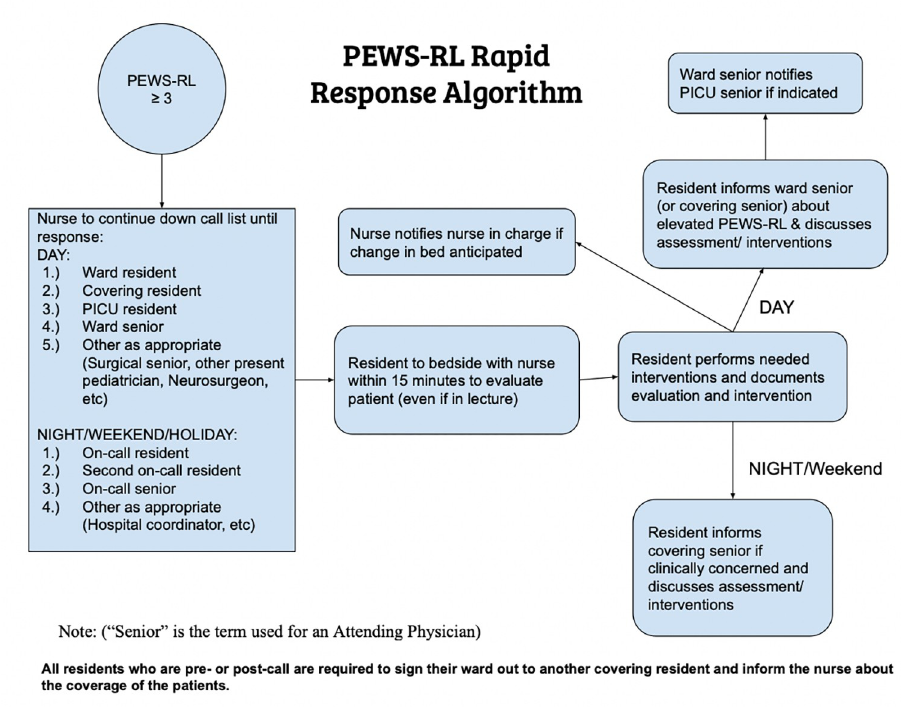
Fig 1. CHUK PEWS-RL rapid response